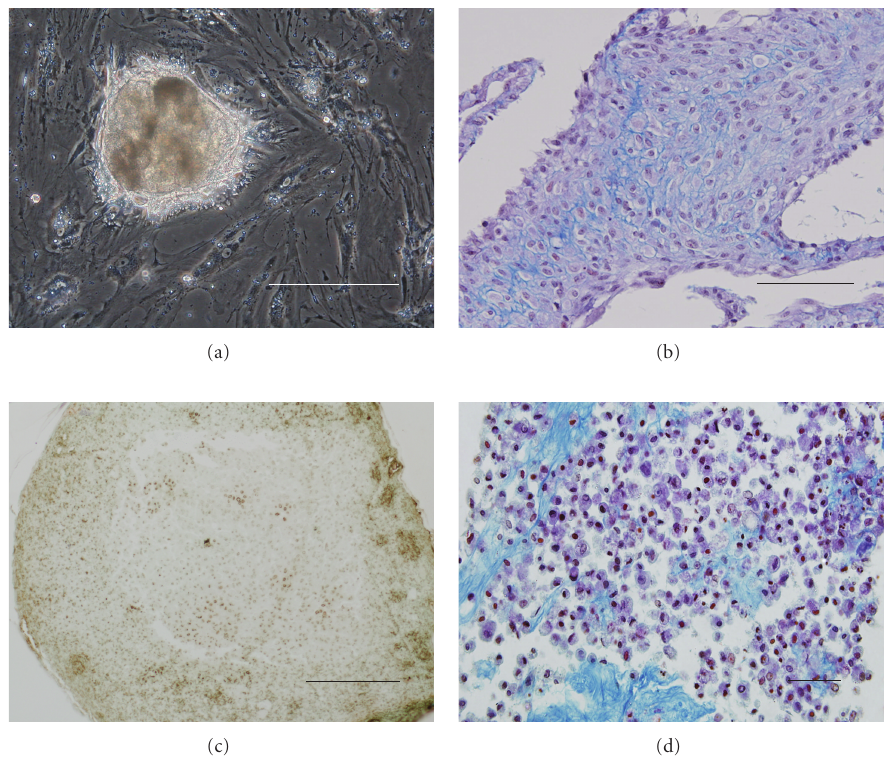
Figure 5: Osteogenic and chondrogenic potential of DPSCs. (a) Phase contrast micrograph of osteogenic nodule after 4 week-cultivation in di ff erentiation medium. (b) Histological examination revealed multilayered structure consisting of osteoblast-like cells surrounded by extracellular matrix containing collagen fibres; Ladewig blue trichrome. (c) Immunoperoxidase histochemistry of osteonectin confirmed the presence of this bone-specific glycoprotein that links minerals to collagen within the micromass pellets. (d) Chondrogenic micromass bodies were composed of cells and extracellular matrix. Alcian blue staining confirmed the presence of sulphated acidic glycosaminoglycans, a principal component of cartilaginous ground substance. Scale bars (a)-(b) 100 μ m, (c) 200 μ m, (d) and 50 μ